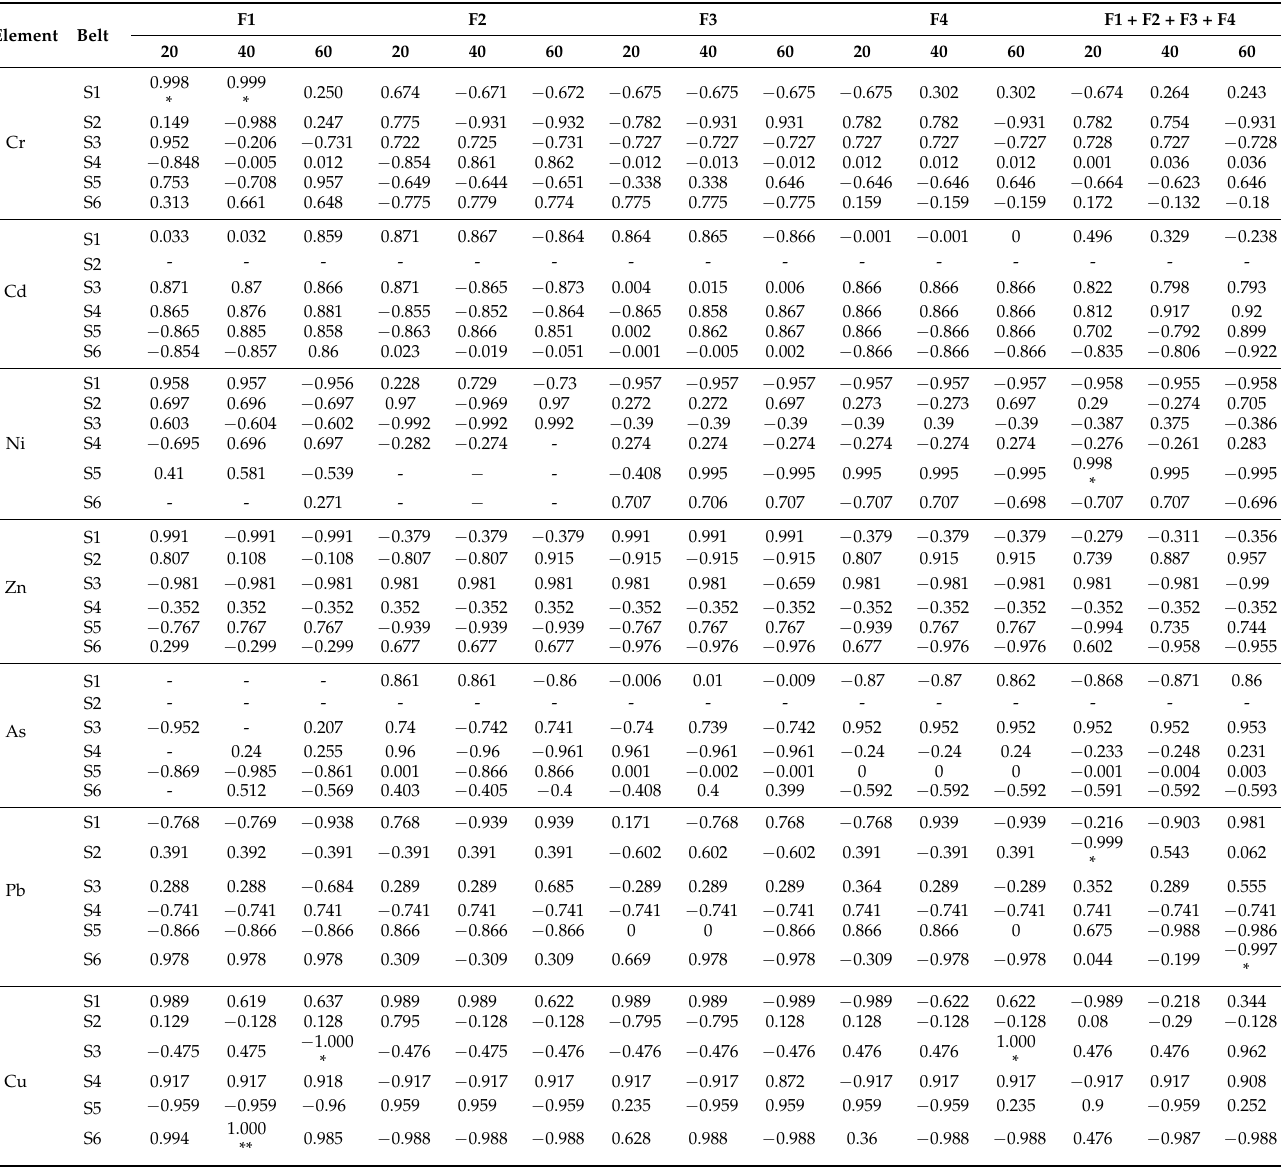
Table 6. Correlation coefficients for the relationships between heavy metal concentrations in tea leaves and fractions F1–F4 extracted from